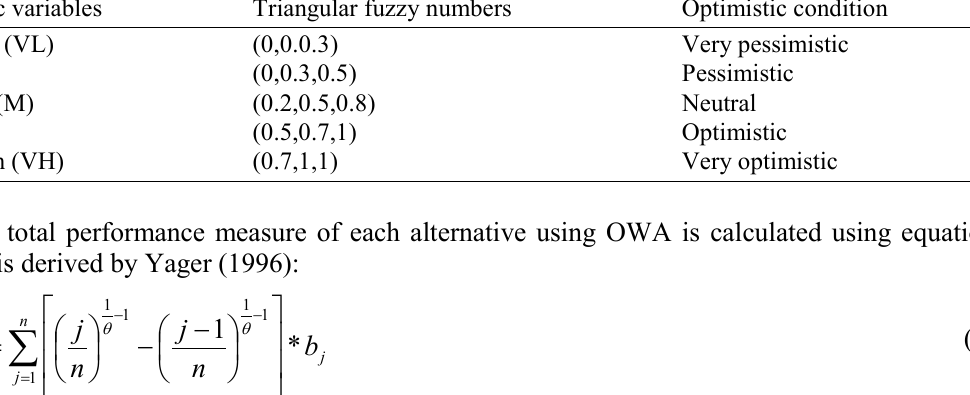
Table 2 Relations between fuzzy numbers and linguistic quantifiers for optimism degree evaluations. Linguistic